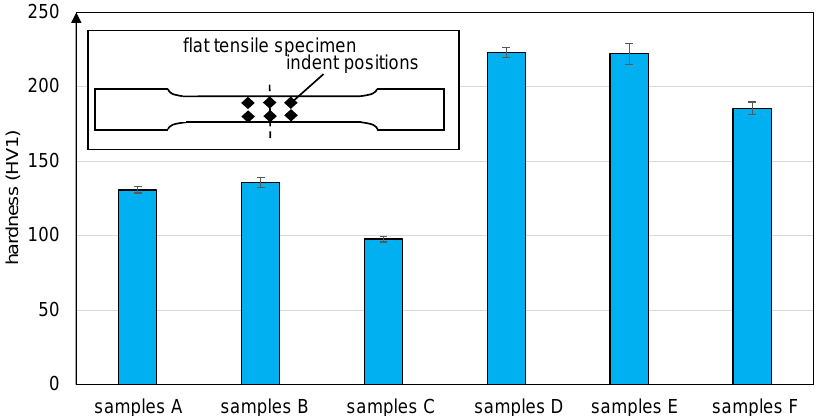
Figure 4. Hardness values for DC04 and DP600 flat tensile specimen in delivery state and superimposed oscillated and oscillation-free 15% pre-stretched levels.